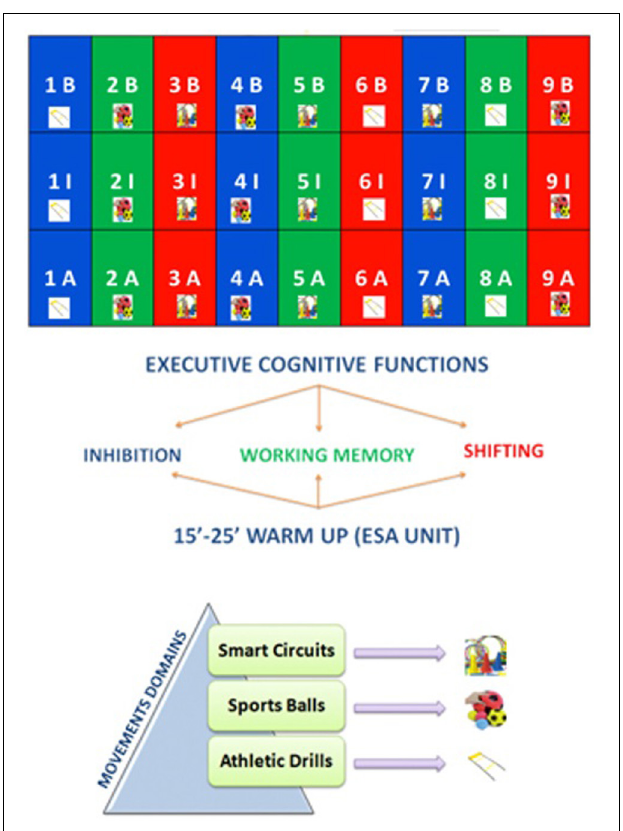
FIGURE 1 | The Enriched Sports Activity (ESA) Program